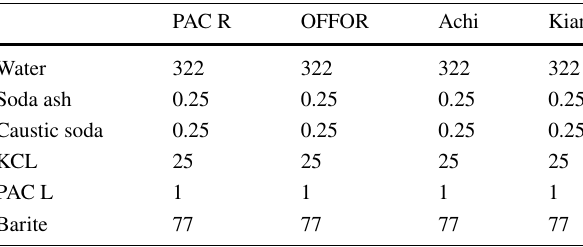
Table 1 The water-based mud systems formulation composition